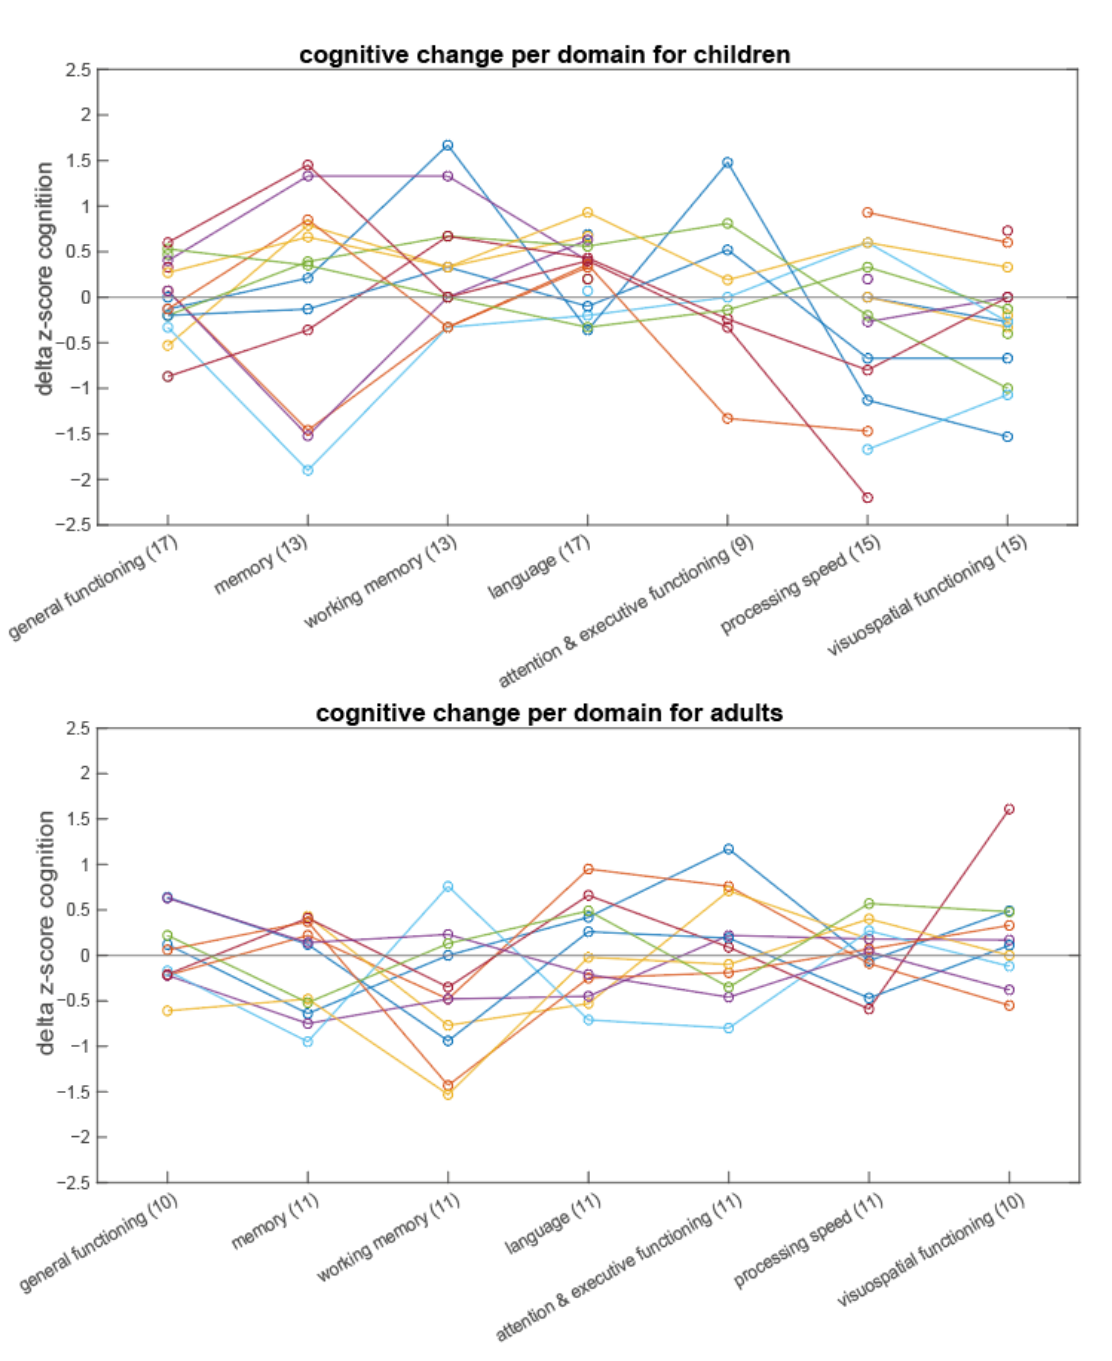
Figure A1. Cognitive change per domain. Change in cognitive domain per operatively treated patient. This graph shows the variability in cognitive scores between domains and between patients. Each color represents a single patient. The lines are used to connect the dots for easier comparison; consequently, the directional coefficient of the lines does not hold meaningful value. The numbers represent the number of valid test scores per domain.